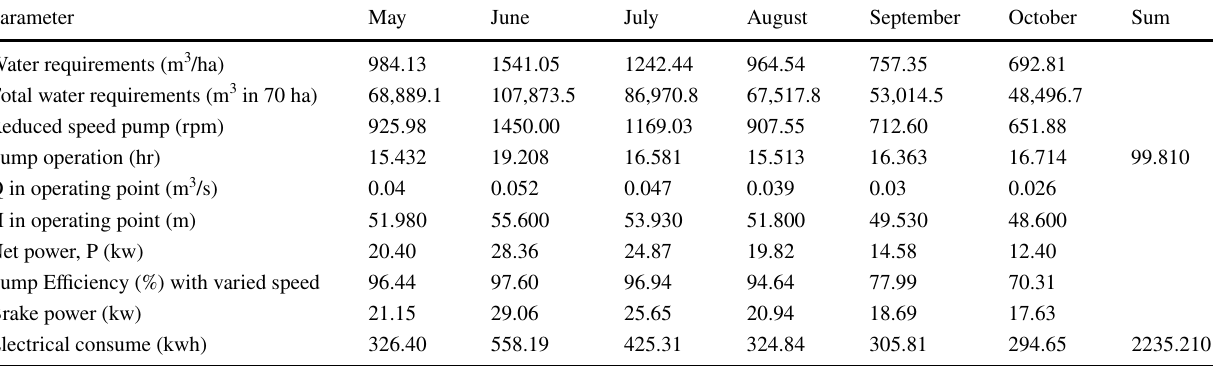
Table 5 Calculations of efficiency, brake power and electricity consumption of the sprinkler irrigation system using a variable speed pump (VSP) Parameter